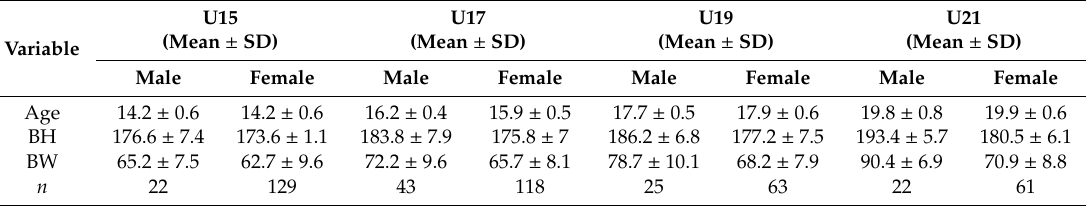
Table 1. Descriptive statistics of subject